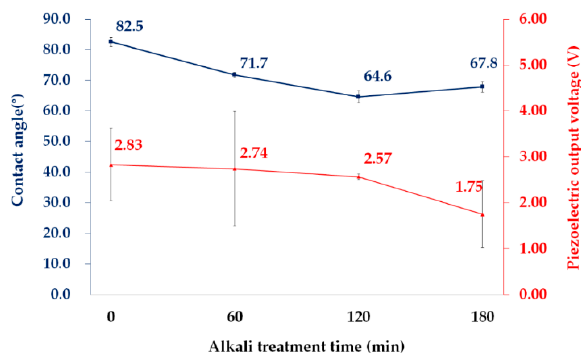
Figure 2. Water contact angle and piezoelectric output voltage of the PVDF film treated with an NaOH solution.